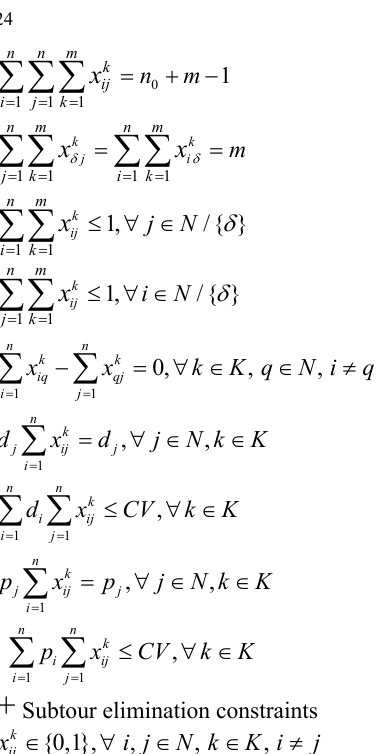
table characterizes with the assistance of which the words, representing the pattern are listed in a lexicographic or dictionary order. During the search for an optimal word, when a partial word is considered, first bounds are determined and then the partial words for which the value is less than the trail value are checked for the feasibility ”. The basic concepts associated with Lexi-search algorithm (LSA) are described